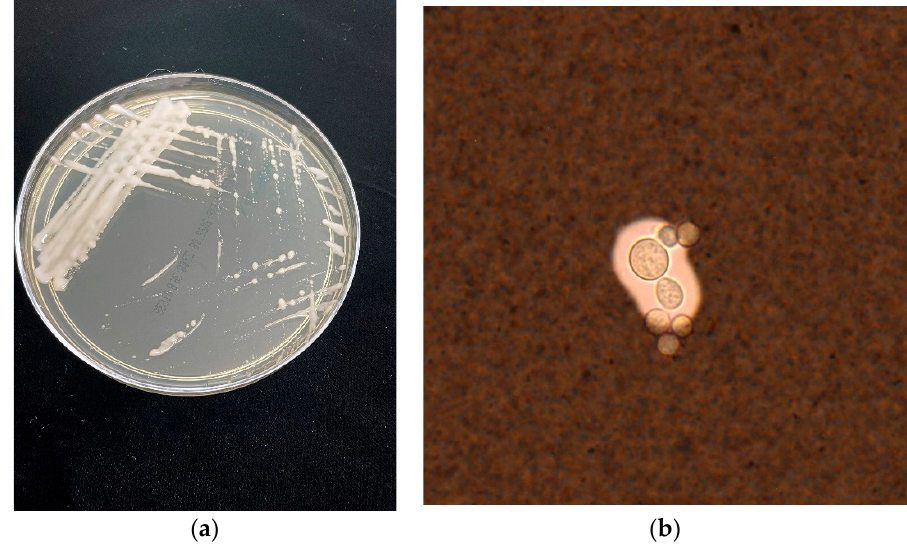
Figure 1. ( a ) Cryptococcus gattii growing on Sabouraud dextrose agar ( b ) C. gattii strained with India Ink.